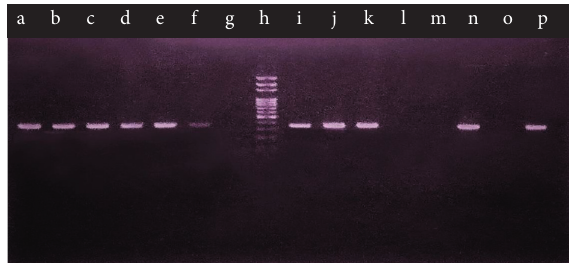
Figure 4: Agarose gel (1%) electrophoresis of PCR assay of the toxA gene (352 bp). a b, c d, e f, i j, k, and n: toxA -positive P. aeruginosa isolates, g, l, and m: toxA -negative P. aeruginosa isolates, h: 100bp marker, o: negative control (nuclease-free water), and p: positive